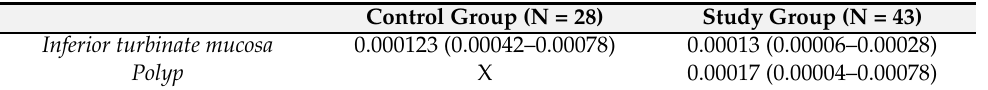
Table 3. Median (25–75%) of TAS2R38 receptor expression levels normalized to β -actin in polypoid tissue and inferior turbinate tissue.